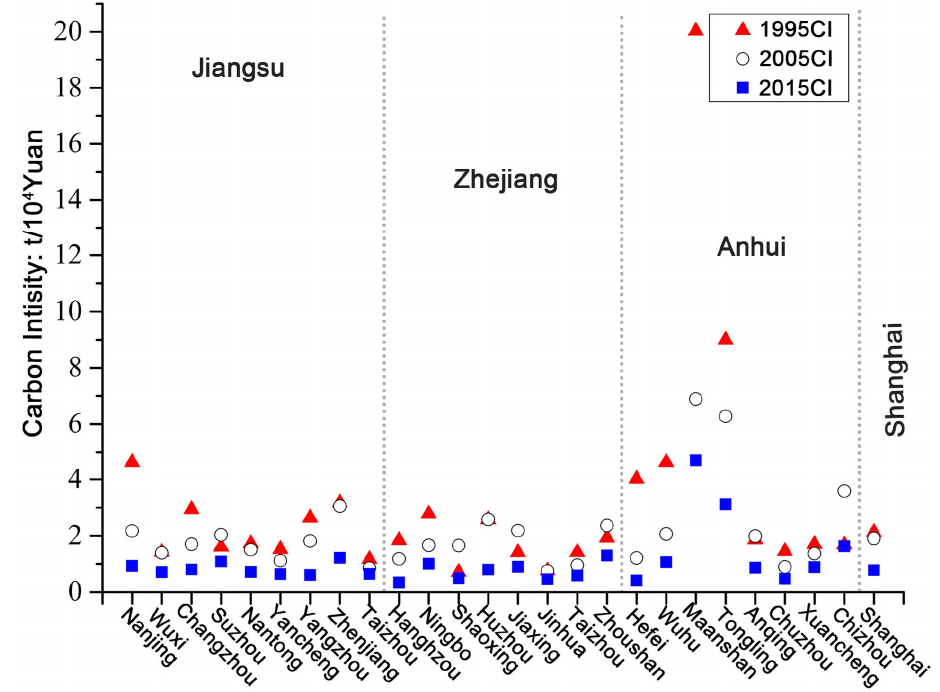
Figure 6. Carbon intensities (CI) for the 26 YRDUA cities from 1995 to